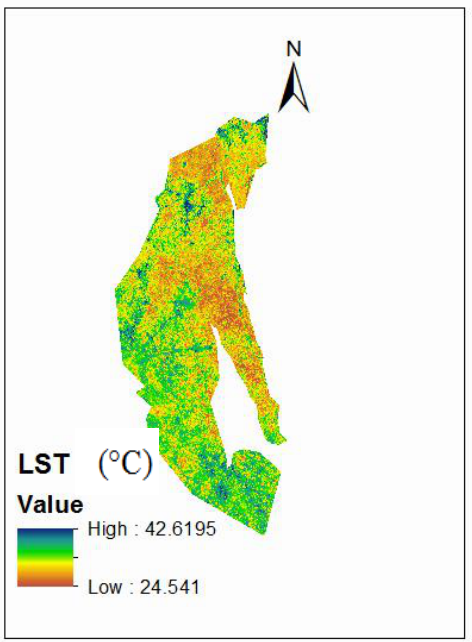
Figure 2. Land Surface Temperature map of UGC